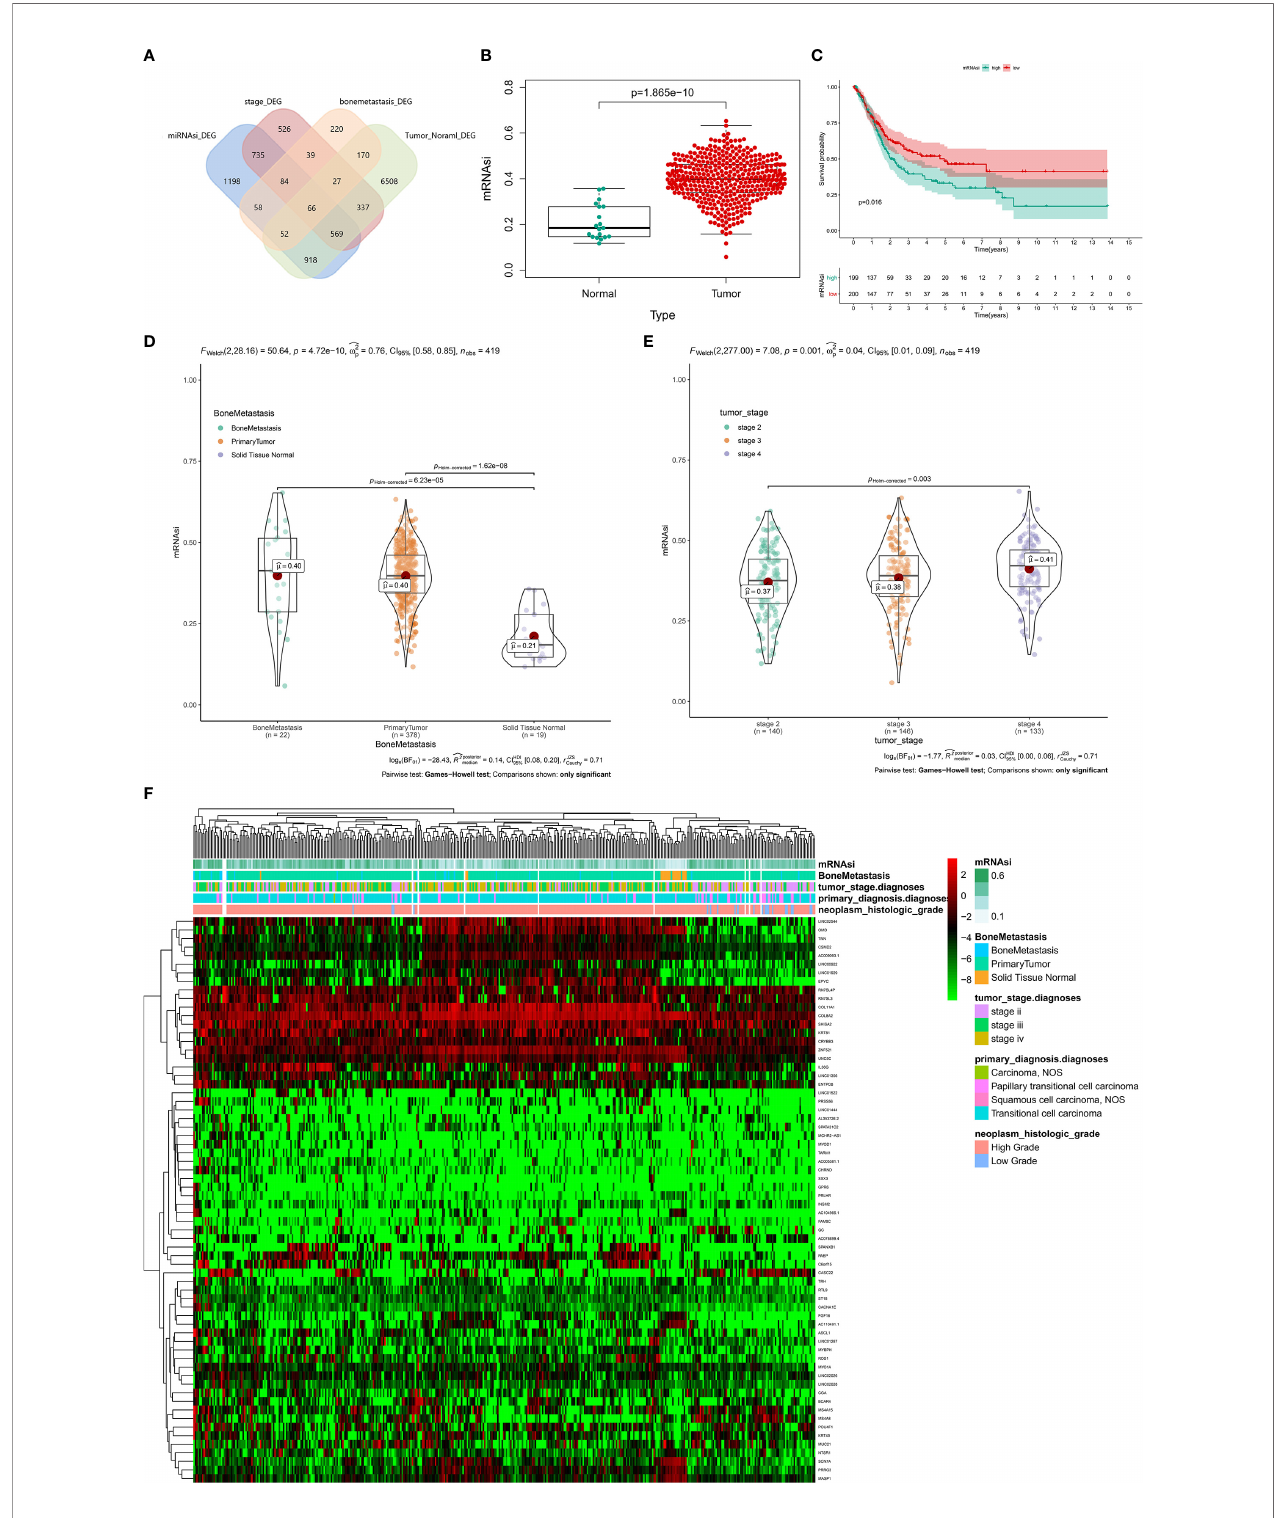
FIGURE 6 | The clinical relevance of mRNAsi and identi fi cation of stemness-related genes. (A) The Venn plot of the tumorigenesis-, stemness-, stage- and bone metastasis-related differential expressed genes. (B) The difference of mRNAi between normal and tumor group. (C) Kaplan-Meier survival analysis of mRNAsi between normal and tumor group. (D) The difference of mRNAi among normal, tumor and bone metastasis. (E) The difference of mRNAi among different clinical stage. (F) The heatmap of mRNAsi, bone metastasis, tumor stage, primary diagnosis and neoplasm histologic